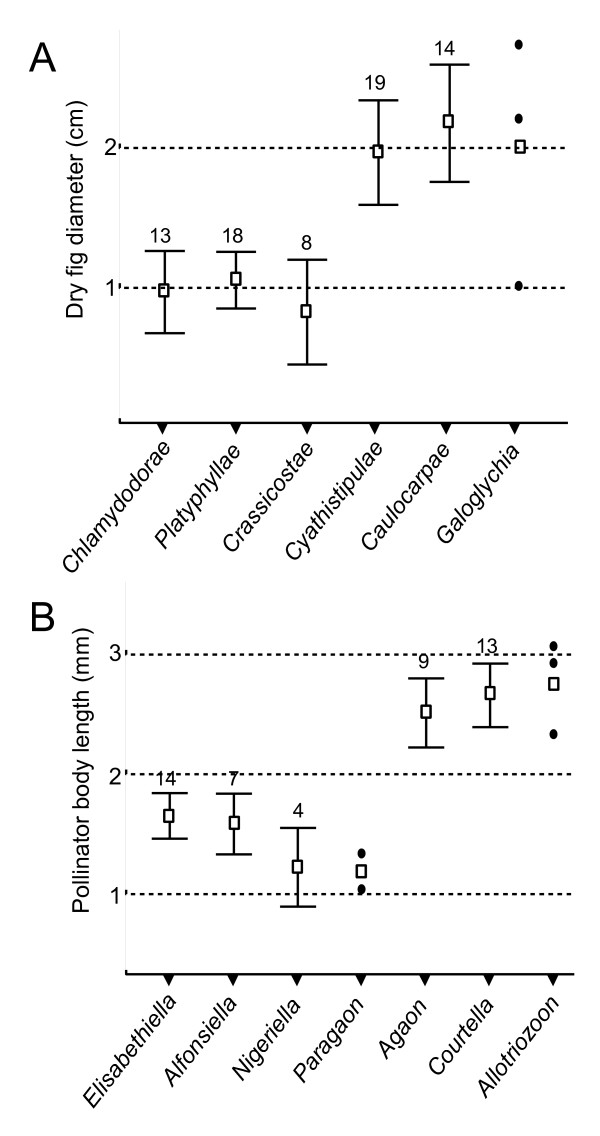
Mean dry fig diameter and mean pollinator body length for each subsection of section Galoglychia and each pollinating wasp genus. Figures above whiskers give the number (n) of species included in the mean calculation. Whiskers give 95% credible interval (provided when n>3, otherwise single values are plotted).